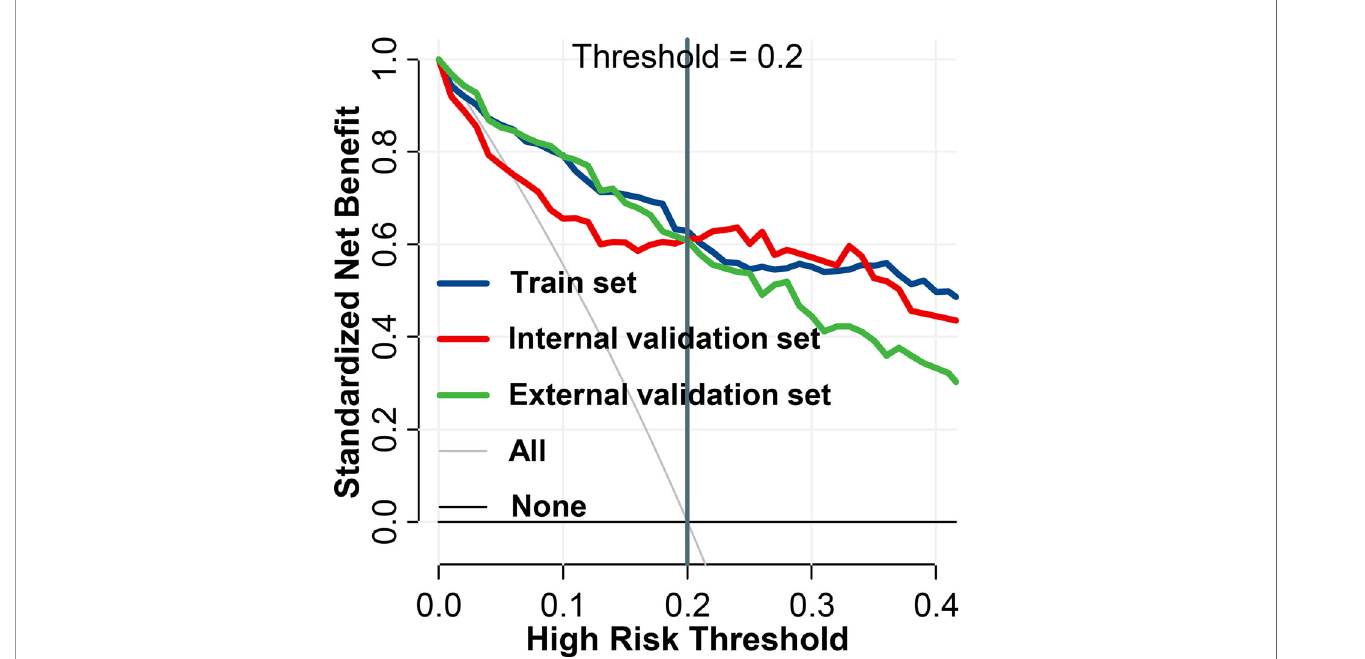
FIGURE 5 | Decision curve analysis of BTI4mm model for invasion diagnosis. For the training and validation sets, the net bene fi t curve is shown. When threshold probability reached 0.20, the clinical bene fi t of the models was the